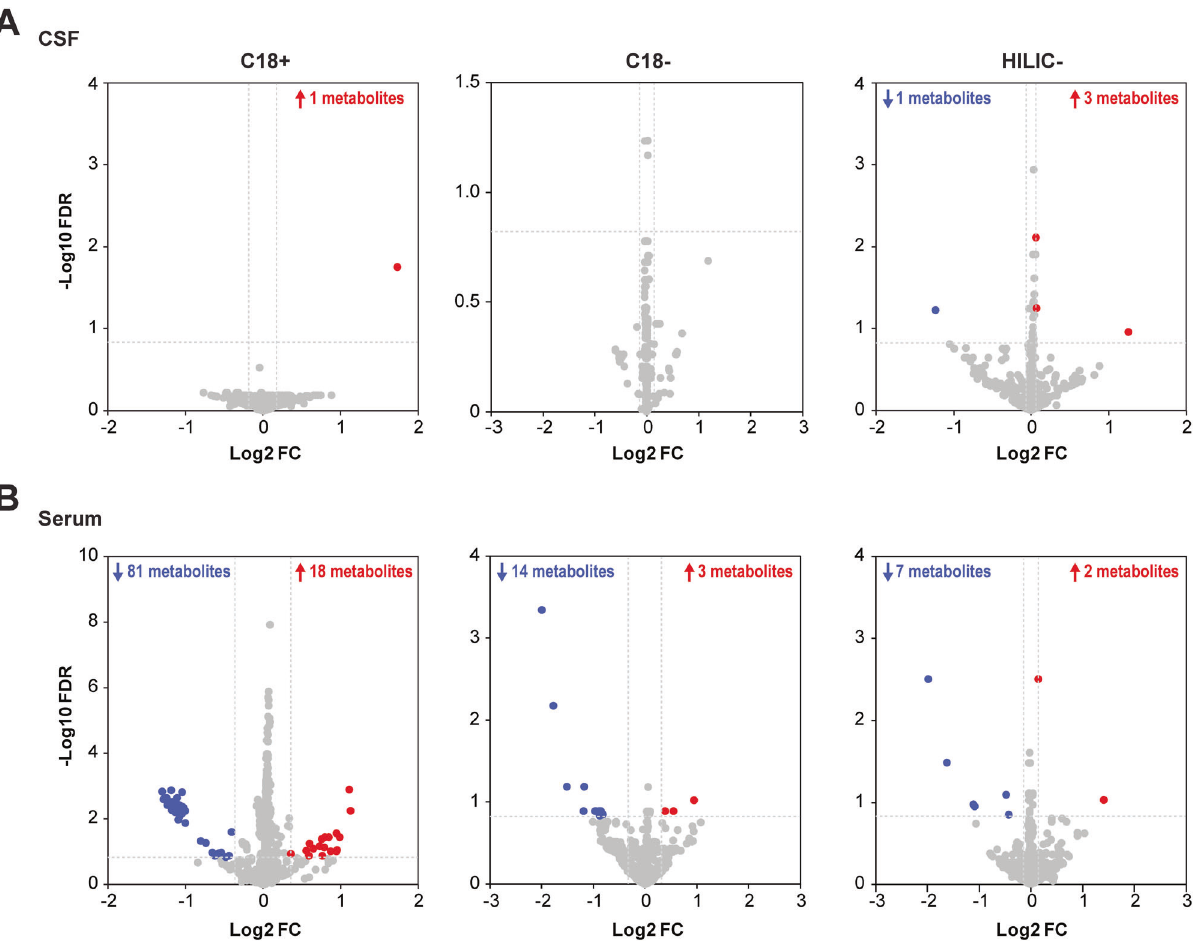
Fig. 1 Volcano plots of psychosis-associated metabolites by detection modes. Each sample was subjected to all combinations of liquid chromatography (C18 or HILIC columns) and electrospray ionization (positive or negative) to maximize metabolite detection. Data for serum subjected to HILIC + detection were discarded due to heterogeneities after normalization. A CSF metabolite changes in C18 + , C18 − , and HILIC − modes (from left to right). B Serum metabolite changes in C18 + , C18 − , and HILIC − modes (from left to right). Statistical signi fi cance was set at FDR < 0.15 (vertical gray lines) with a fold change threshold which was set at the top 5% of most variable metabolites comparing between baseline and follow-up in healthy controls for each mode (horizontal gray lines; Supplementary Table 3 and 4). Signi fi cantly down- regulated metabolites are colored in blue while signi fi cantly up-regulated metabolites are colored in red. (Abbreviations: C18, C18 column; CSF, cerebrospinal fl uid; HILIC, hydrophilic interaction liquid chromatography column; + , positive electron ionization; − , negative electron